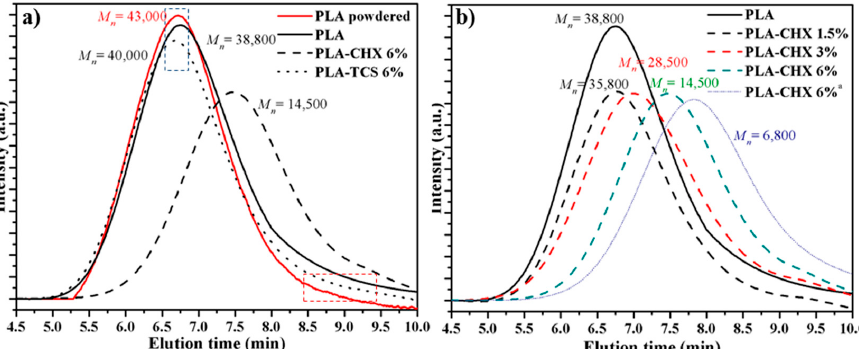
Figure 6. ( a ) Gel permeation chromatography (GPC) curves determined of initial powdered PLA, the molded PLA and its mixtures with the maximum assayed amounts of triclosan (TCS) and CHX; ( b ) comparison between GPC curves of processed PLA and PLA mixtures with the indicated percentages of CHX. For the sake of completeness, the curve corresponding to a molten PLA film loaded with 6 wt-% of CHX is also drawn (dotted curve).